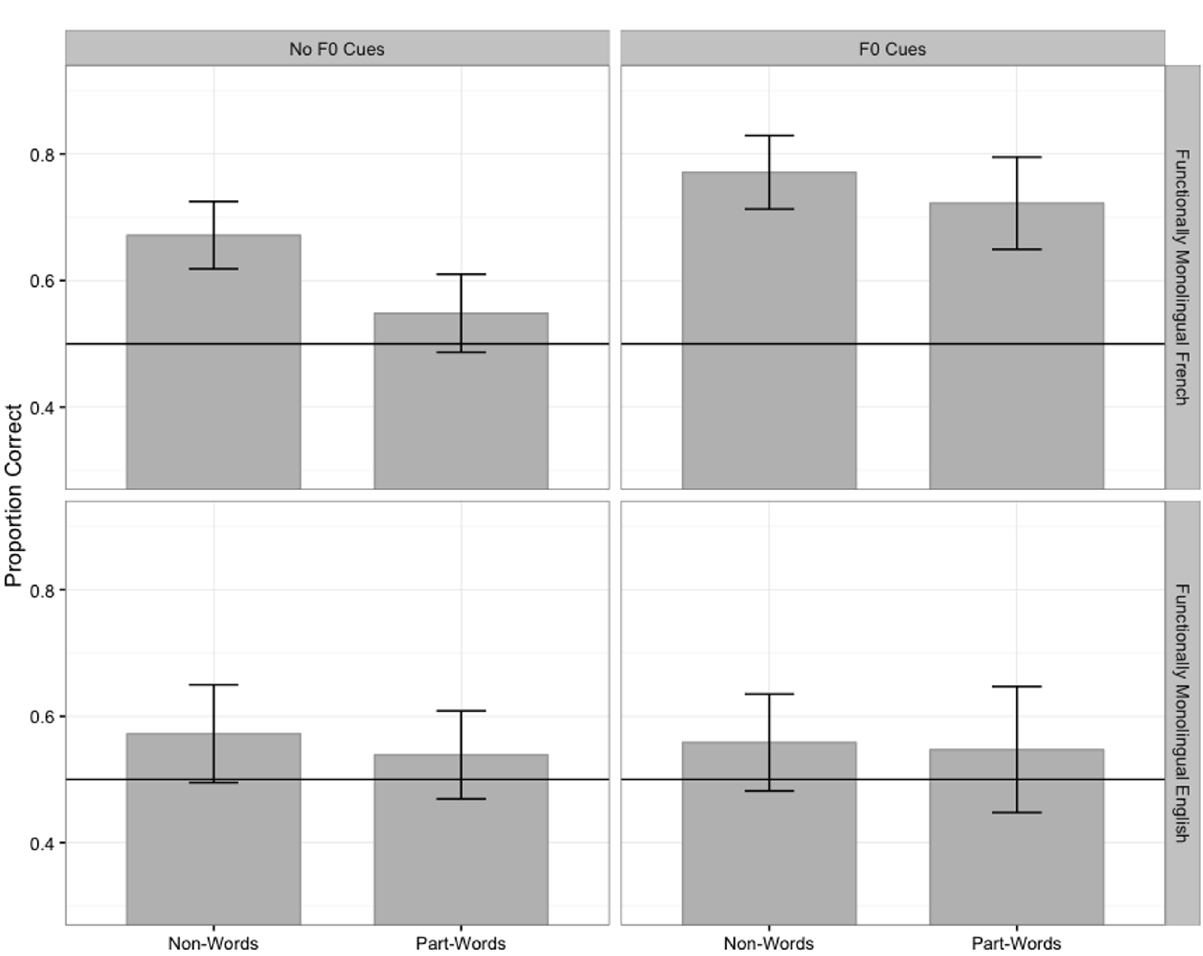
Fig 2. Functionally monolingual French and English listeners’ mean proportions of correct responses in the conditions without and with F0 cues to word-final boundaries. The error bars represent one standard error of the mean; the horizontal line represents chance performance.